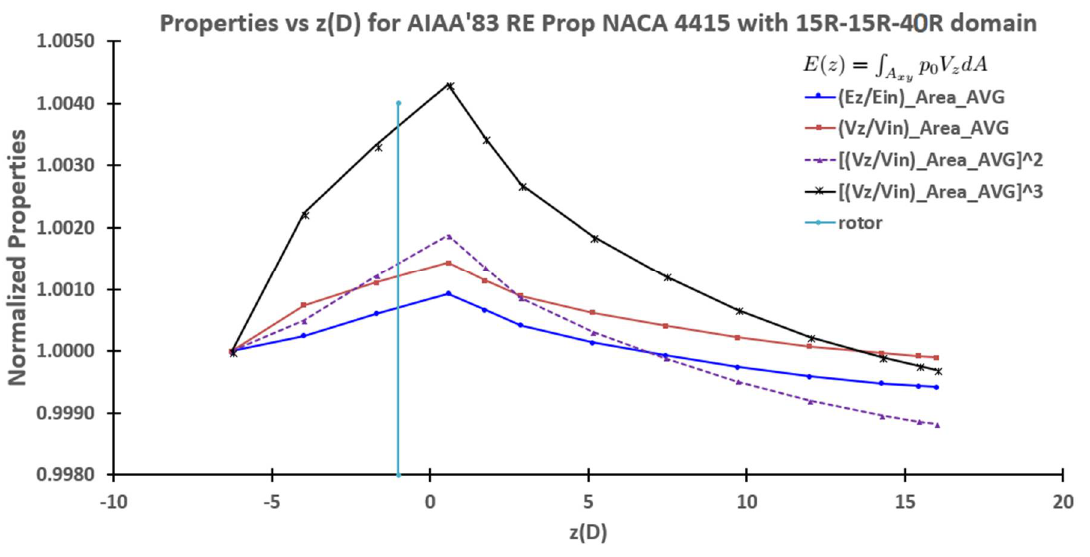
Figure 22. Area-averaged velocity and energy normalized with inlet values at several locations for 3X_40R domain (15R-15R-40R).